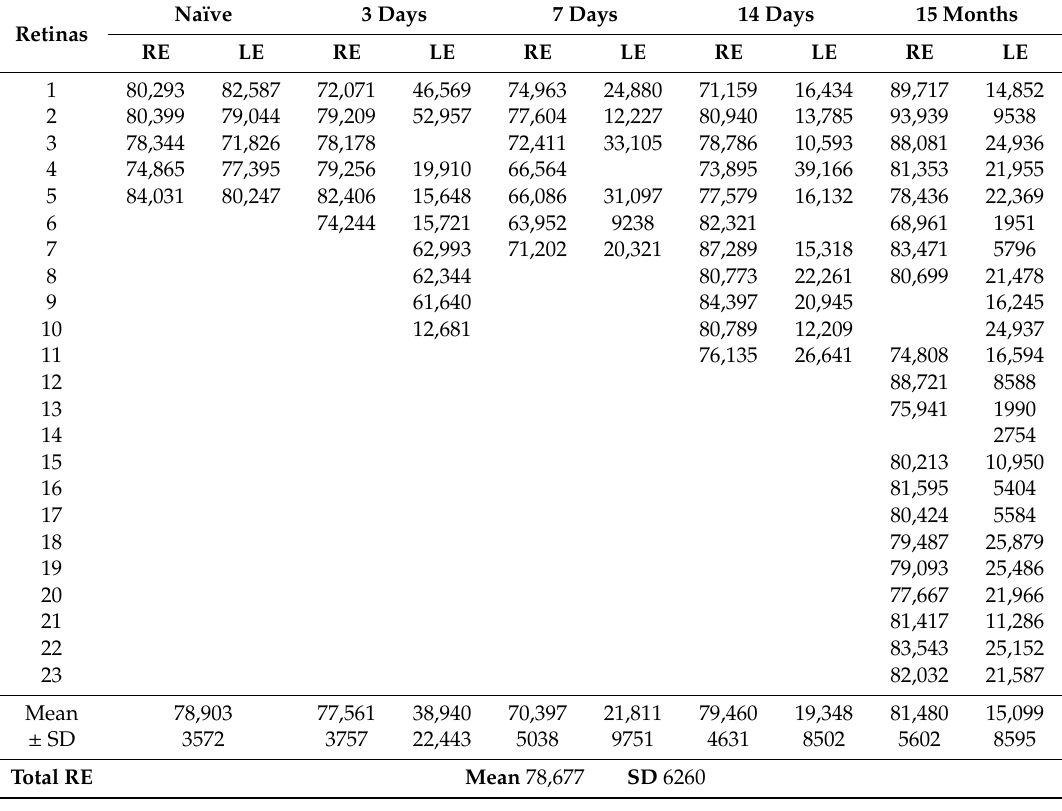
Figure 3. ( A – E ) Isodensity maps showing the retinal topography of Brn3a + RGCs in intact retinas ( A ) or in representative retinas analyzed at 3 ( B ), 7 ( C ), 14 ( D ) days, or 15 ( E ) months after intravitreal injection of 100 nM NMDA. ( A’ – E’ ) Neighbor maps illustrating the distribution of m + RGCs in the same retinas shown